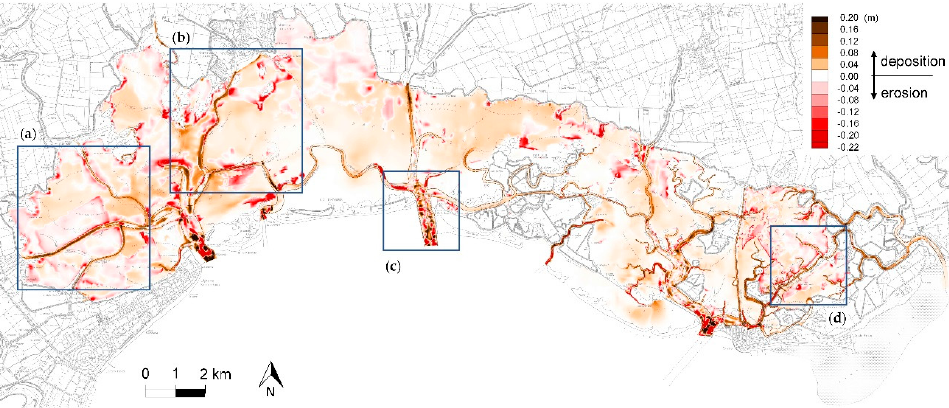
Figure 11. Morphological evolution of the lagoon over a period of an average year with erosion and deposition areas. (a–d): panels shown in detail in Figure 12a–d.